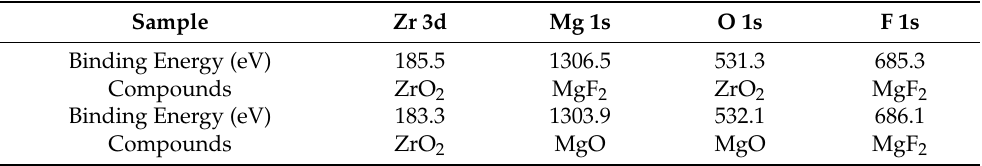
Table 4. The binding energy of the main elements and corresponding compounds for MAO coatings formed in orthogonal experiment